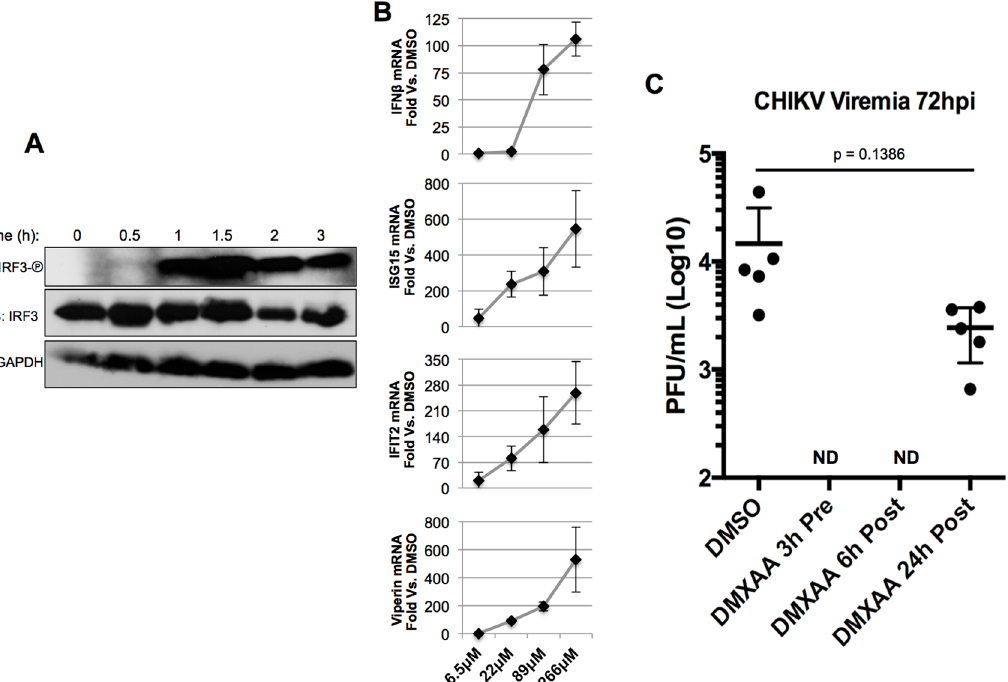
Fig 11. Innate Immune Activation by and Antiviral Activity of DMXAA. A. Immunoblot of lysates from murine RAW264.7 cells following exposure to 100 μ M DMXAA for indicated time showing phosphorylation status of IRF3 S386, total IRF3, and GAPDH. (B) mRNA synthesis of indicated genes in RAW264.7 cells following 8h exposure to indicated concentration of DMXAA. Values represent average mRNA fold change ± SD from duplicate experiments relative to cells exposed to 1% DMSO. (B) Levels of serum-associated CHIKV at 72h post infection. Five mice per group were treated with DMSO alone or DMXAA at 3h pre- or 6h or 24h post inoculation as